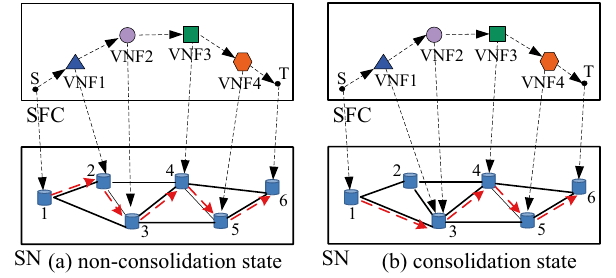
Figure 2. Comparison between consolidated and non-consolidated